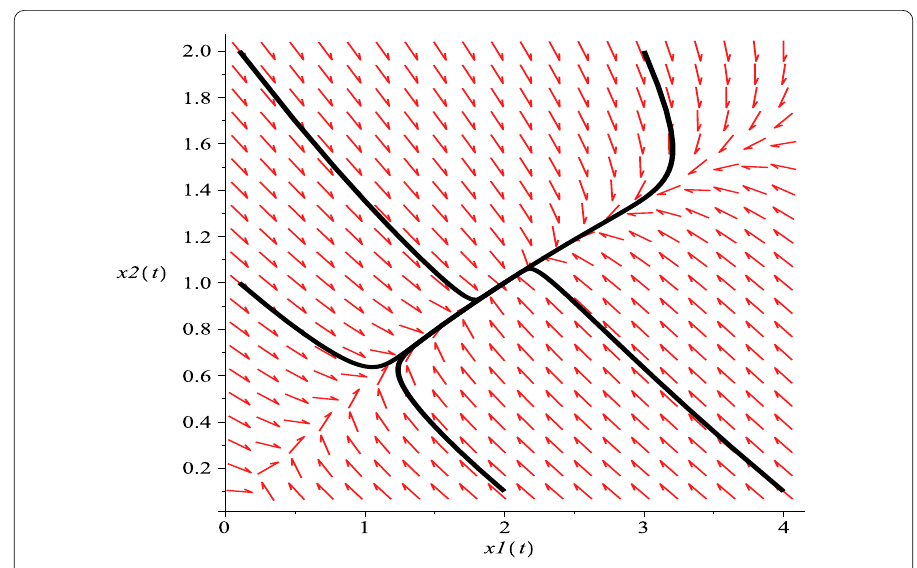
Figure 1 Dynamics behavior of system (5.2), the initial conditions ( x 1 (0), x 2 (0)) = (4,0.1), (3,2), (0.1,2), (0.1,1), and (2,0.1), respectively